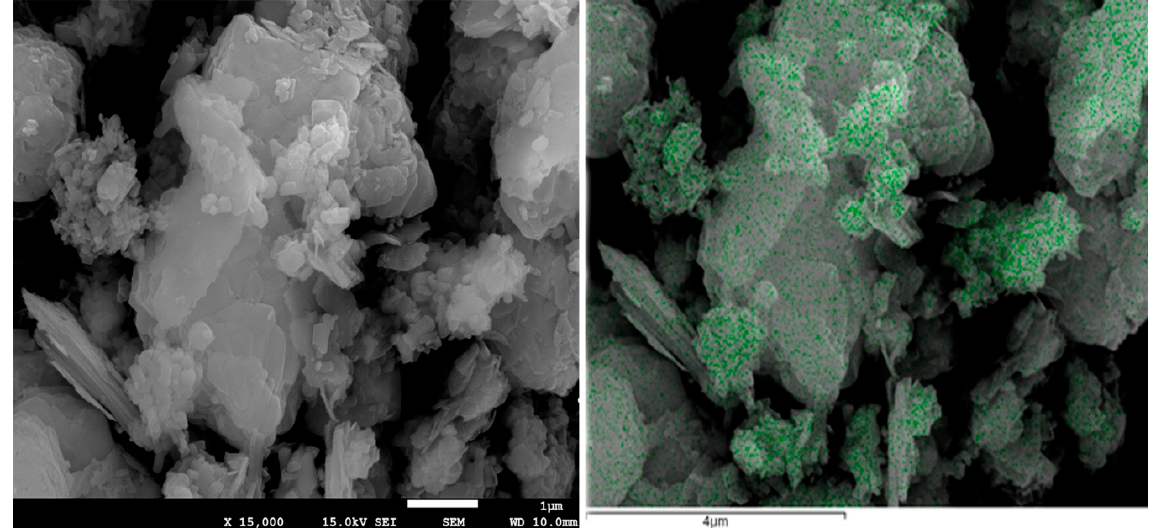
Figure 2. Morphology of the red mud (the green parts represent Na). Table 1. Main chemical composition of Bayer red mud measured by X-ray fluorescence.